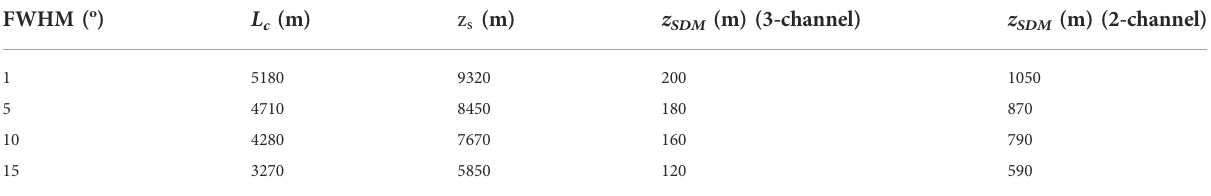
patterns become broader, thus increasing crosstalk among the three co-propagating channels. At coupling length L c = 5,180 m (Figure 2D), where the highest order guiding modes centered their mode-distribution at θ = 0, the EMD is achieved. At z s = 9,320 m, an SSD is established (Figure 2E). One should see from Figure 2E that the solid line, dashed line and dotted line, which represent angular power distributions for different launch angles, are overlapped at fi ber length z s at which SSD is established. This unique angular power distribution, shown as a solid line, became fi xed and centered, denoting that an SSD is established. Mode coupling restricts the length of the proposed MM MC SOF at which an ADM may be implemented, as can be seen. In each carrier seven cores of the investigated MM MC SOF, a three- channel ADM (with launch angles θ 0 = 0, 4, and 8) and two- channel (with launch angles θ 0 = 0 and 8 ° ) can be realized at a maximum length of 200 m (Figure 2A) and 1,050 m (Figure 2B), respectively.